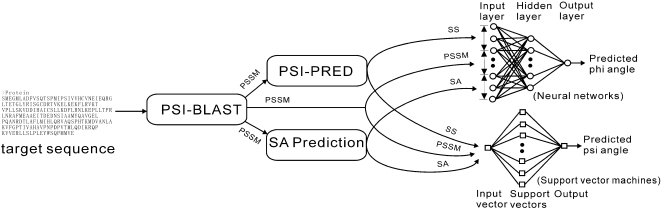
Flowchart of ANGLOR for the phi and psi angle predictions.Three sets of features, position-specific scoring matrix (PSSM), secondary structure (SS) and solvent accessibility (SA), are used as inputs of two machine-learning predictors (neural networks and support vector machines) for phi and psi separately.